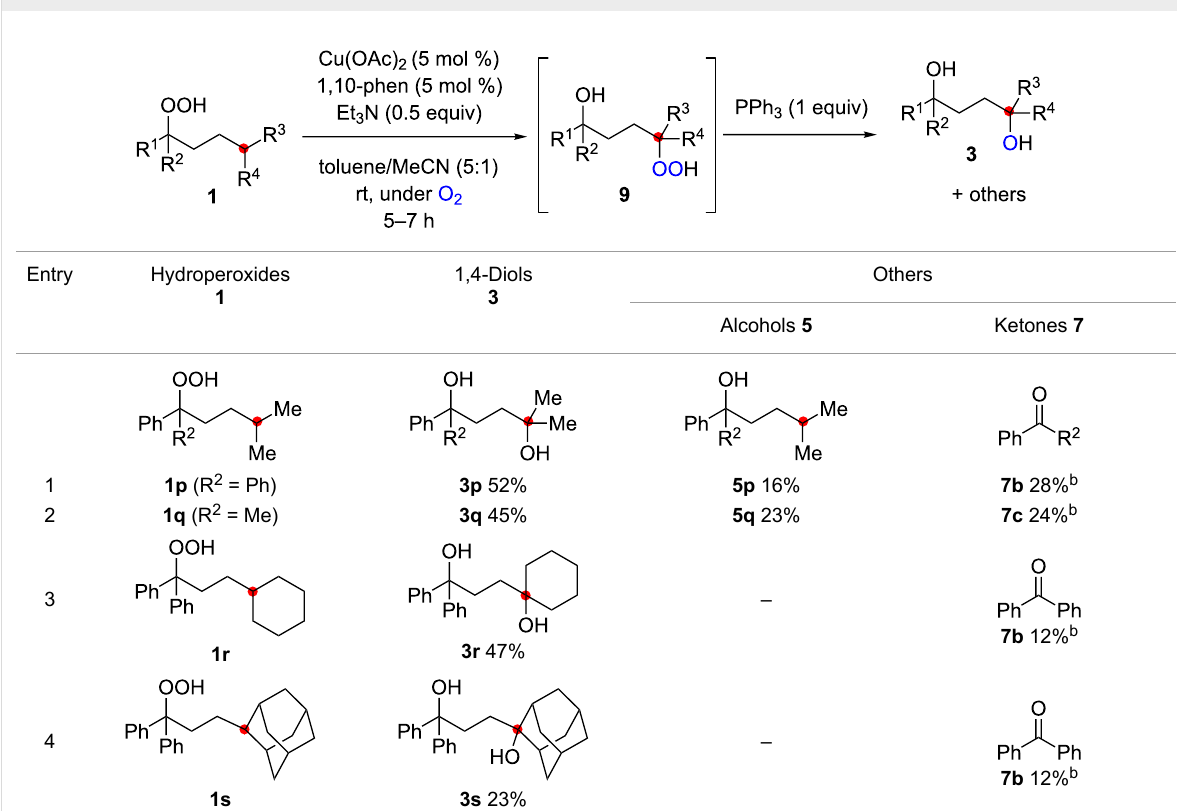
Table 3: Substrate scope oxygenation of tertiary C–H bonds.